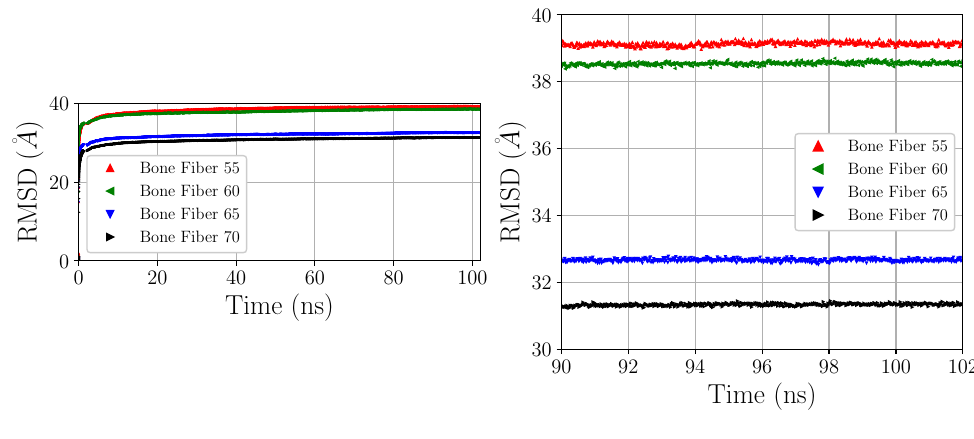
Figure 9. RMSD of Bone Fiber models (with respect to devised models, frame